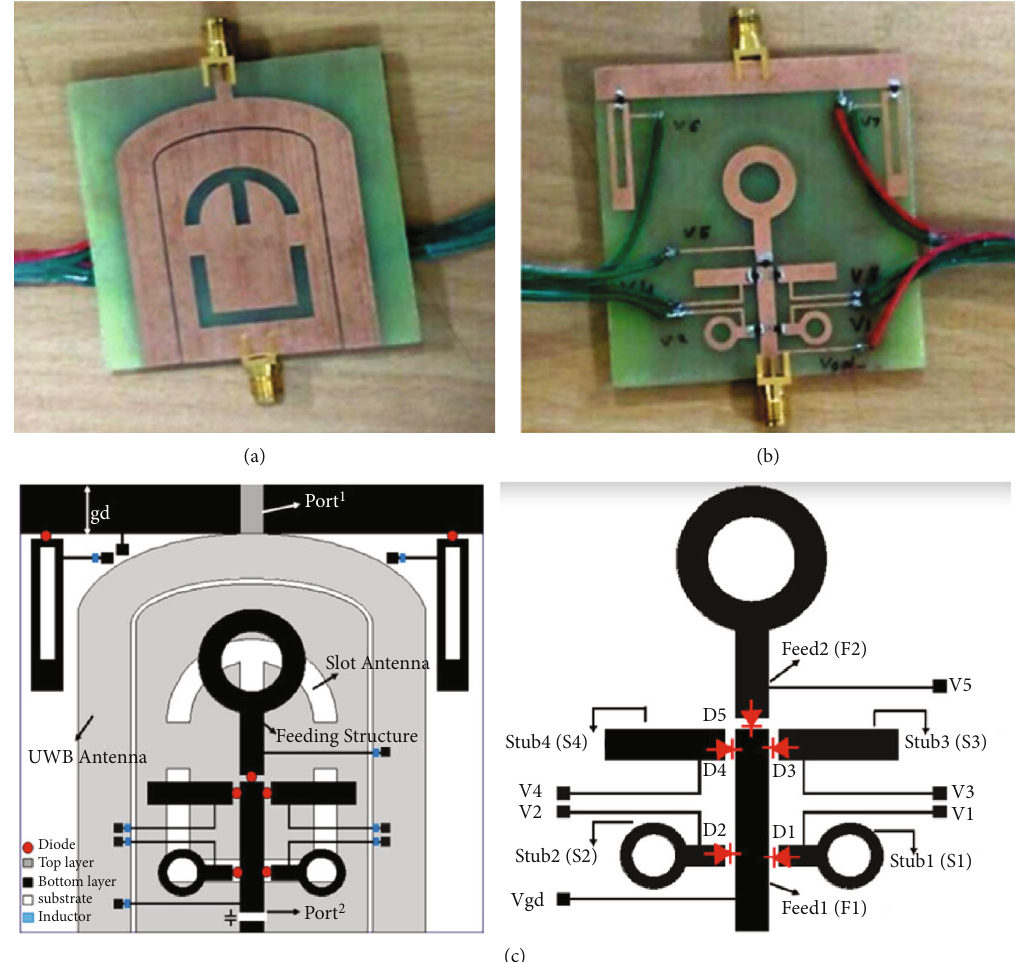
Figure 11: Fabricated layout of recon fi gurable antenna using PIN diode: (a) top view; (b) bottom view; (c) measurement